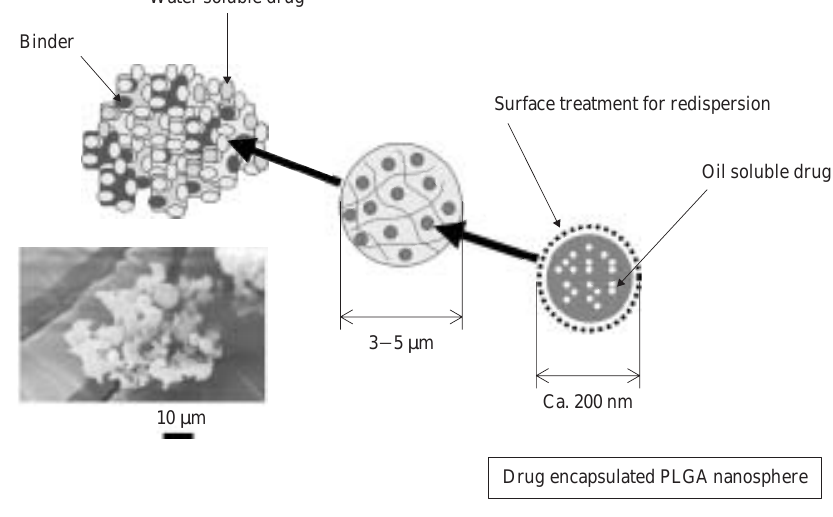
Structure of functional composite particle consisting of drug encapsulated PLGA